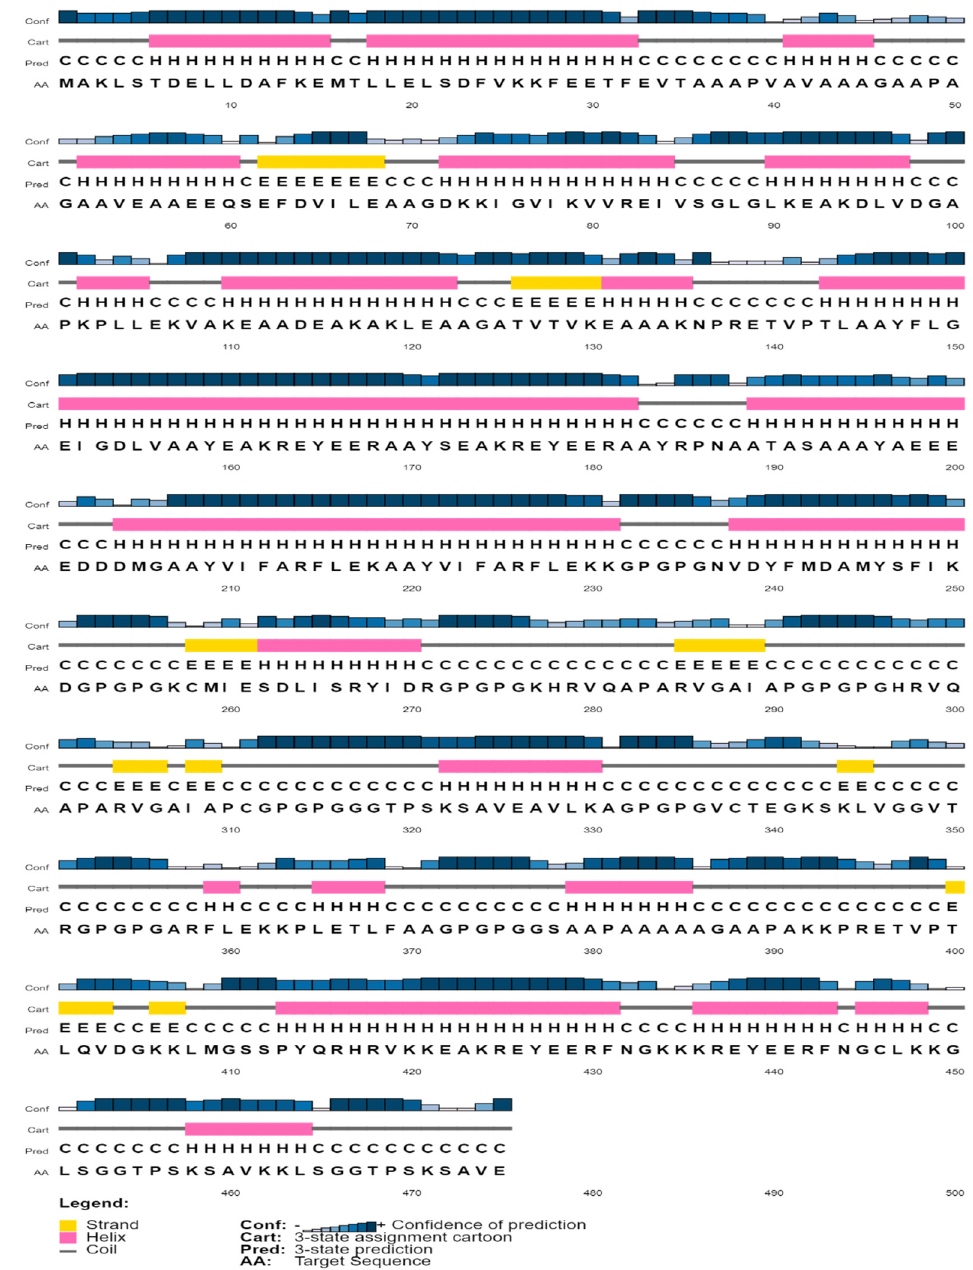
Figure 4. Prediction of the secondary structure of designed multi-epitope vaccines using PSI-PRED.